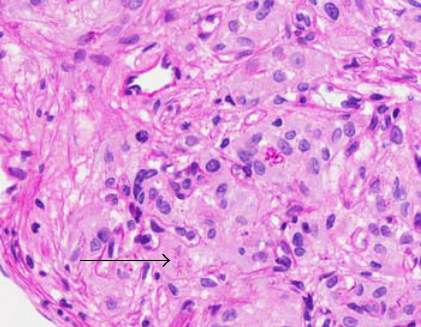
Figure 3: Periodic acid Schiff (PAS) staining on high-powered field. The tumor showed positive stain and it demonstrated characteristic diastase-resistant crystalline structures with rhomboid and rod-like structure in some tumor cells (arrow).